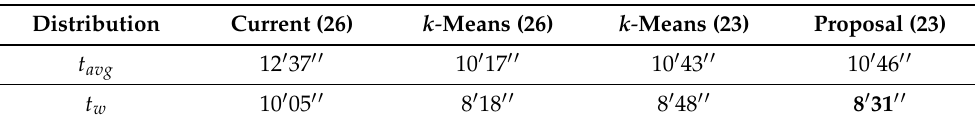
Table 3. Average and weighted times for the current distribution, the k -means distribution with two different numbers of stations and the proposal. The number of fire stations for each distribution is shown in